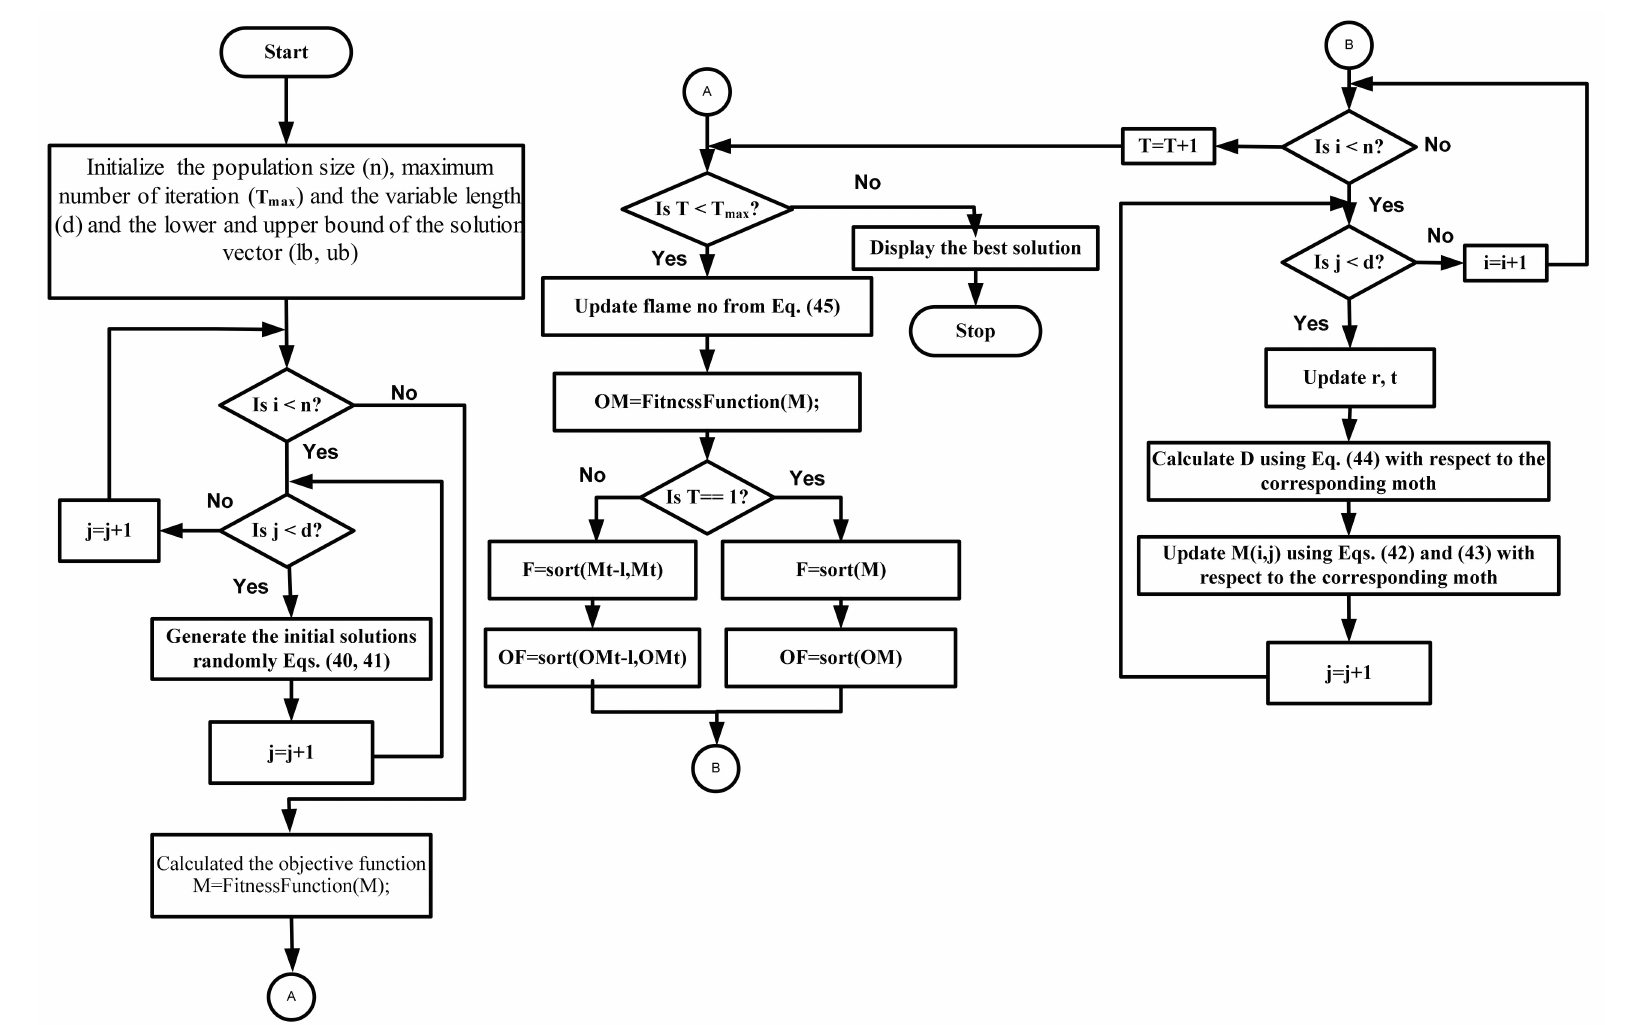
Figure 10. Flow chart of MFO